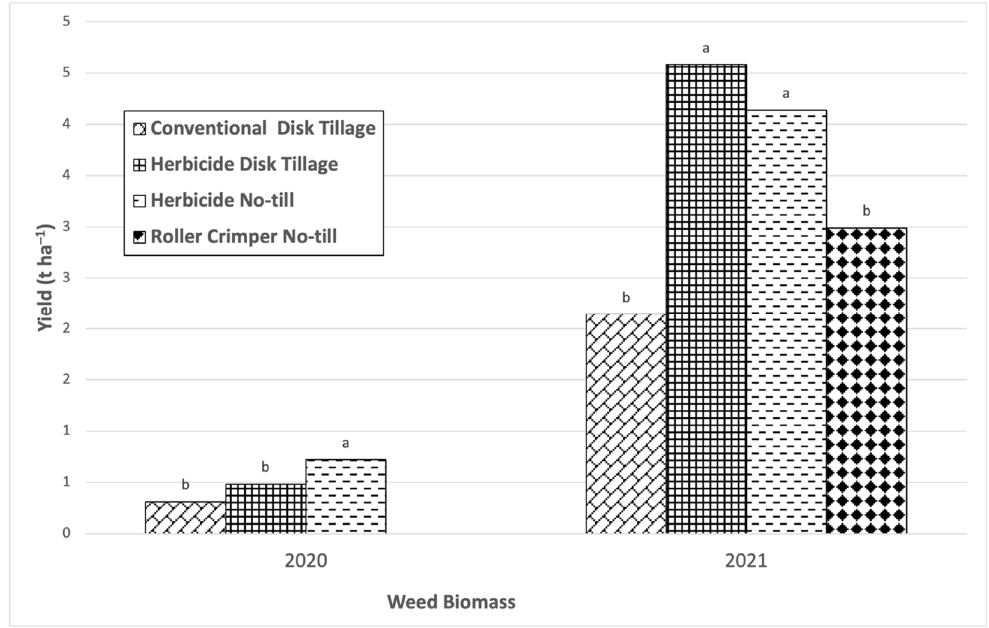
Figure 2. Mean weed biomass as a function of cover crop termination method in 2020 and 2021. For each year, columns marked with the same letter are not significantly different from each other according to Tukey’s HSD adjusted t tests at p ≤ 0.05.